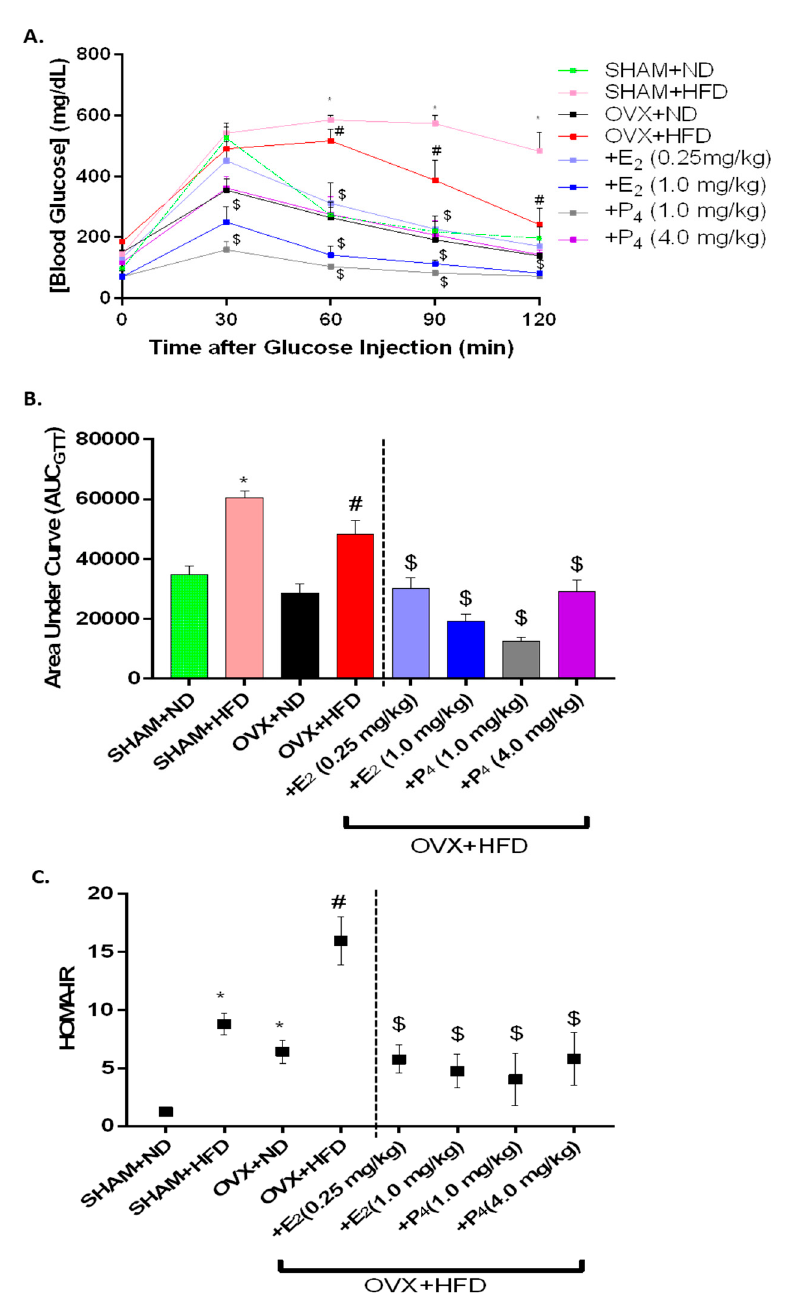
Figure 1. E ff ect of ovariectomy (OVX), 17 β -Estradiol (E 2 ) and Progesterone (P 4 ) on glucose tolerance and insulin sensitivity in high-fat diet (HFD) fed mice. ( A , B ) Intraperitoneal glucose tolerance test (IPGTT) and area under curve (AUC IPGTT) ; ( C ) homeostatic model of insulin resistance (HOMA-IR) plot was calculated using the following formula: fasting blood glucose (mg / dL) × fasting plasma insulin ( µ U / mL) / 405. Data were analyzed using one-way ANOVA by using graph pad prism software. Values are means ± S.E.M. for n = 6 mice. * p < 0.05, significantly di ff erent from normal diet-fed sham-operated (SHAM + ND) mice. # p < 0.05, significantly di ff erent from normal diet-fed ovariectomized (OVX + ND) mice. $ p < 0.05, significantly di ff erent from high-fat diet-fed OVX (OVX + HFD) mice. 3.3. Serum Estradiol, Progesterone, Testosterone, Adiponectin, and Total Nitrite Concentration Serum concentrations of sex steroid hormones [17 β -estradiol, E 2 , progesterone, P 4 ], adiponectin, and total nitrite were measured using commercially available kits and are presented in Table